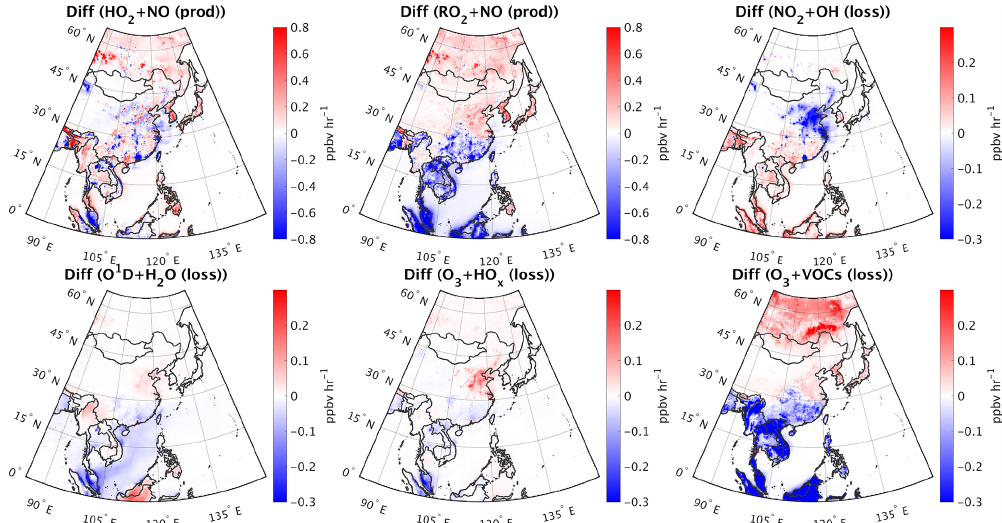
Figure 9. Differences between the simulations with the updated emissions and the default ones of six major pathways of ozone production and loss over the surface. The time period is May–June 2016, 12:00–18:00CST.